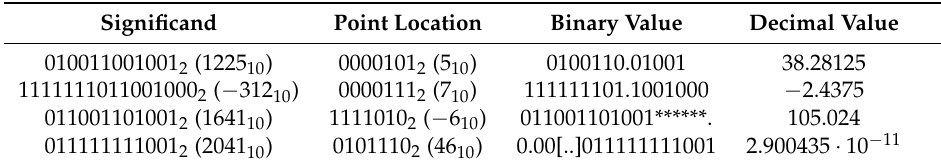
Table 1. Examples of the proposed format.